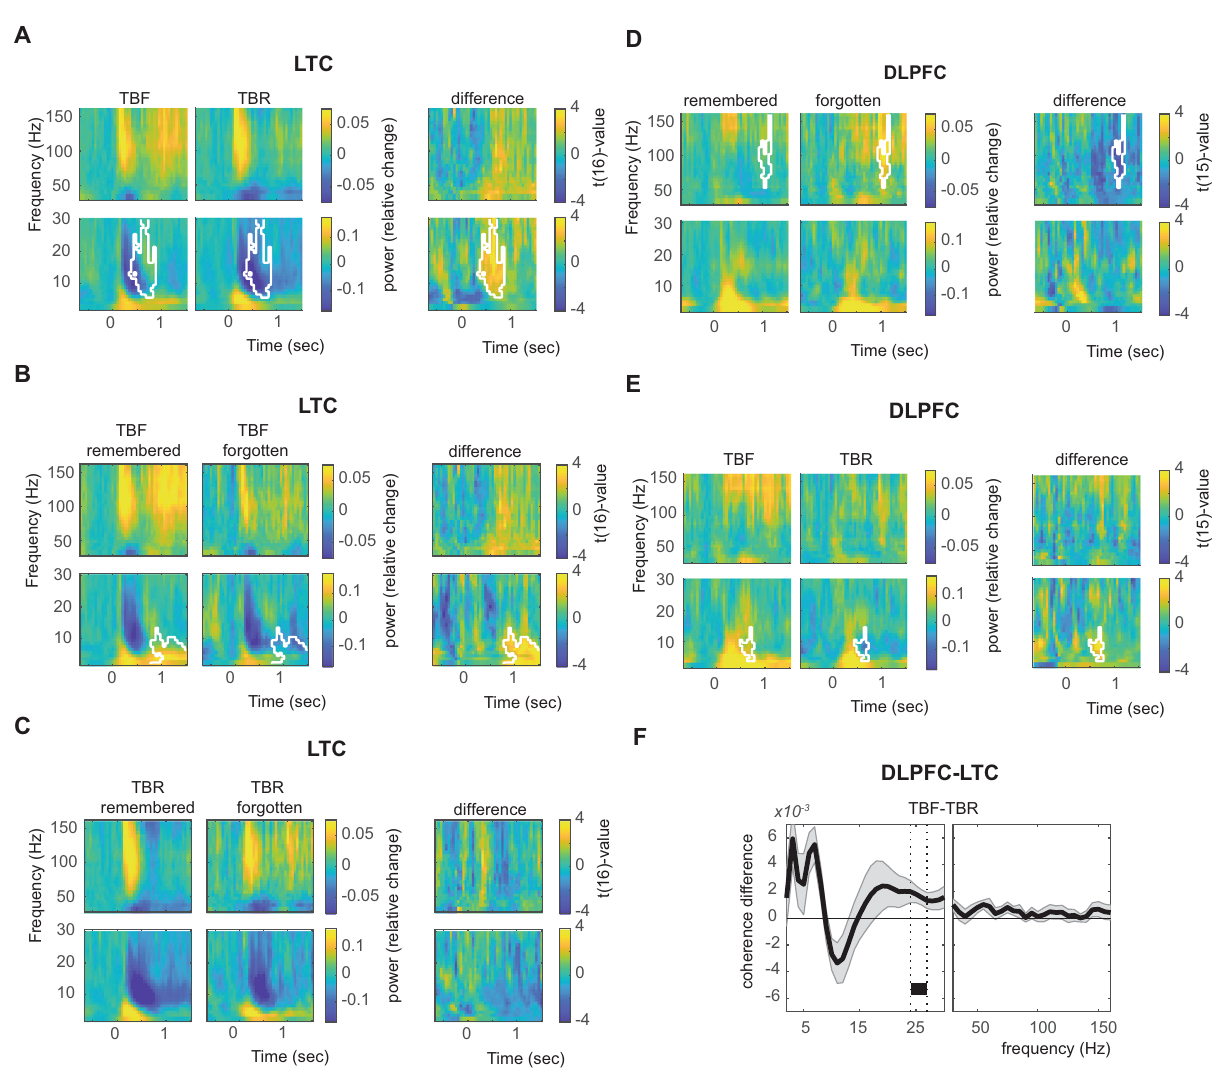
Fig. 7 Cue effects. A Instruction effect on power in lateral temporal cortex (LTC; n = 17). B Memory effect on power in LTC for to-be-forgotten (TBF) items. C Memory effect on power in LTC for to-be-remembered (TBR) items. D Memory effect on power in dorsolateral prefrontal cortex (DLPFC; n = 16). E Instruction effect on power in LTC. F Instruction effect on DLPFC-LTC coherence ( n = 10). Shaded error bars indicate the standard error of the mean. White outlines and black bar indicate signi fi cance at the 0.05 level (cluster corrected). Source data are provided as a Source Data fi